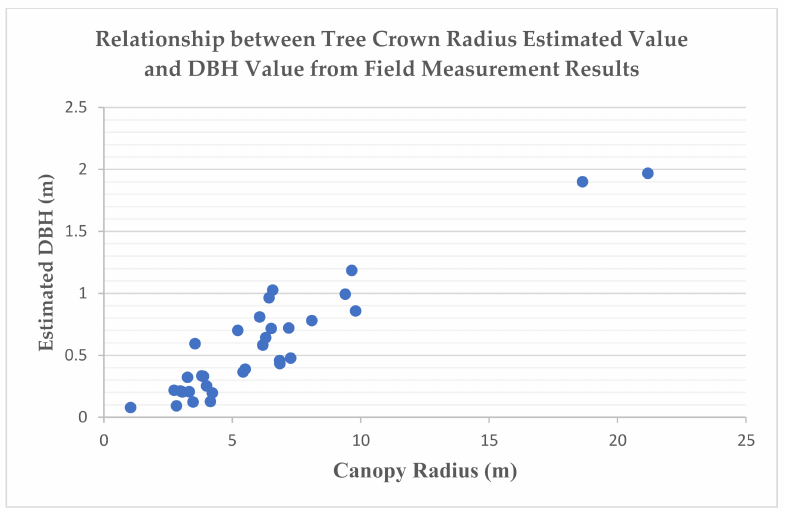
Figure 6. The Scatter Plot of Relationship between Canopy Radius Estimated Value and DBH Value from Field Measurement Results.